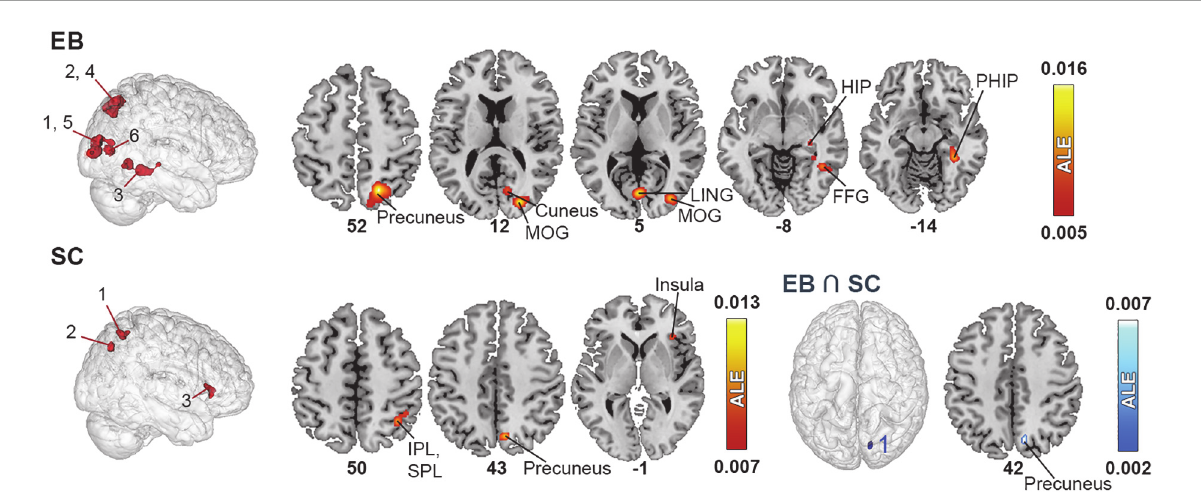
FIGURE3 Brain areas activated by spatial navigation in EB and SC and results of conjunction analysis. (Left) 3D renders of the brain and activation clusters (see Table 4 for reference). (Right) Axial cuts of the brain with identified clusters of activation. The number below the slices refer to the z coordinate in MNI space. The ALE values, calculated for each voxel, represent the probability of activation across included studies (Turkeltaub et al., 2012) and are disclosed to the right. More details regarding the ALE values are presented in Table 4 . FFG, fusiform gyrus; HIP, hippocampus; IPL, inferior parietal lobule; LING, lingual gyrus; MOG, middle occipital gyrus; PHIP,